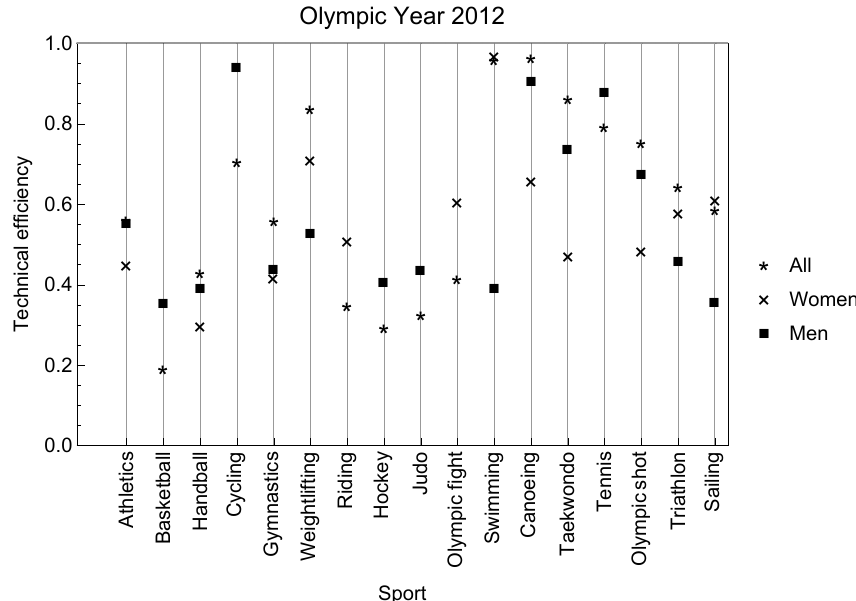
Figure 3. Technical efficiency (Olympic year 2012).